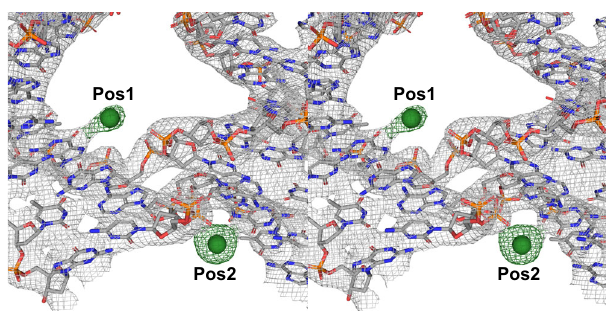
Fig. 4 The junction crossovers contain unique ion binding positions. Stereoscopic view, using J21 in the 4 × 5 system, 2 F o – F c electron density accounting for the bases at the crossover regions are contoured at σ = 2.0, and the individual ion positions 1 and 2 (indicated Pos1 and Pos2) are independently contoured in the corresponding electron density at σ = 4.0. The presence of arsenic at these sites was substantiated by transferring the crystals into TAE-Mg 2 + (40 mM Tris, 20 mM acetate, and 1 mM EDTA pH = 8.6), and subsequently freezing the crystals. The crystals were scanned at the arsenic K edge ( λ = 1.04 Å) where the corresponding arsenate peak was present. No other components within the crystallization buffers could account for the resulting peaks in the F o – F c difference maps for the ions at their corresponding sites. Atoms are indicated using the following: carbon (gray), nitrogen (blue), oxygen (red), phosphate (orange), and arsenic ions (green spheres).